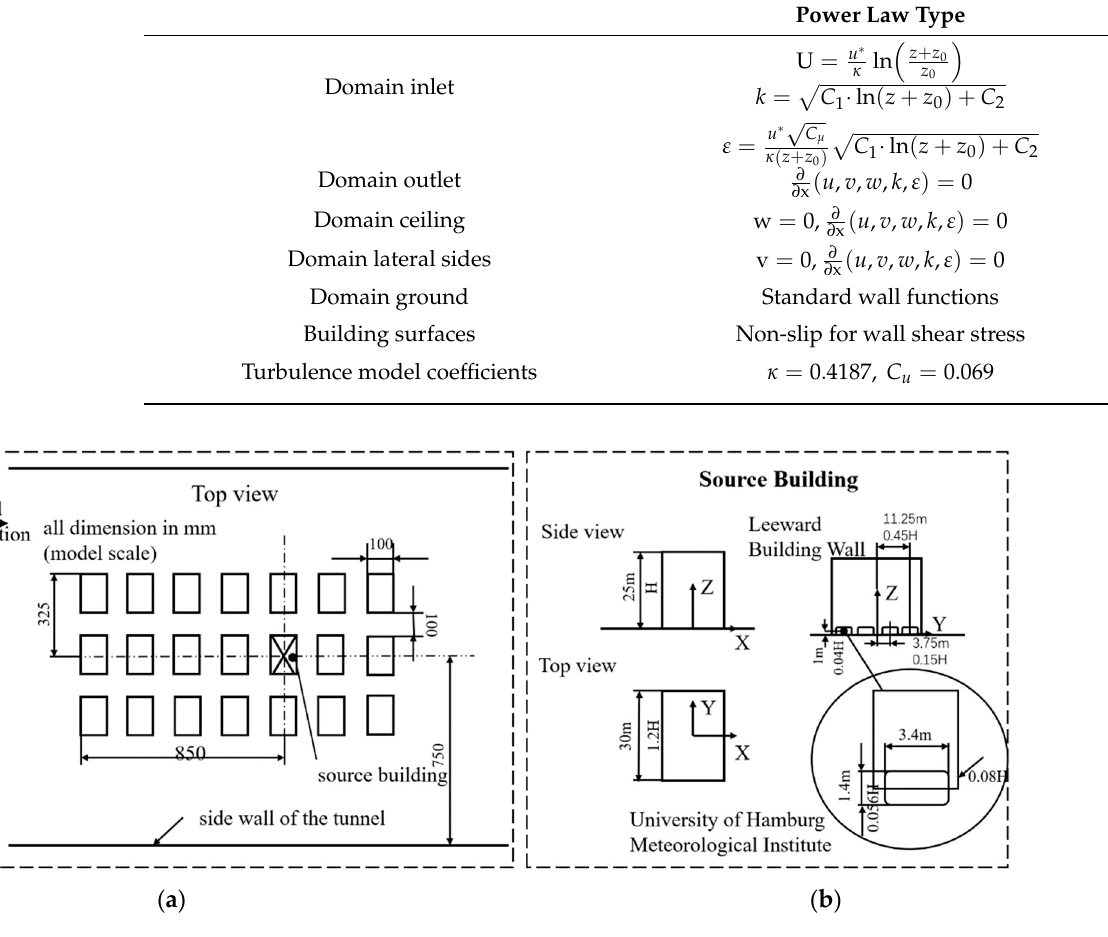
Figure 1. ( a ) Dimensions of building arrays, ( b ) source building and source emissions [45].